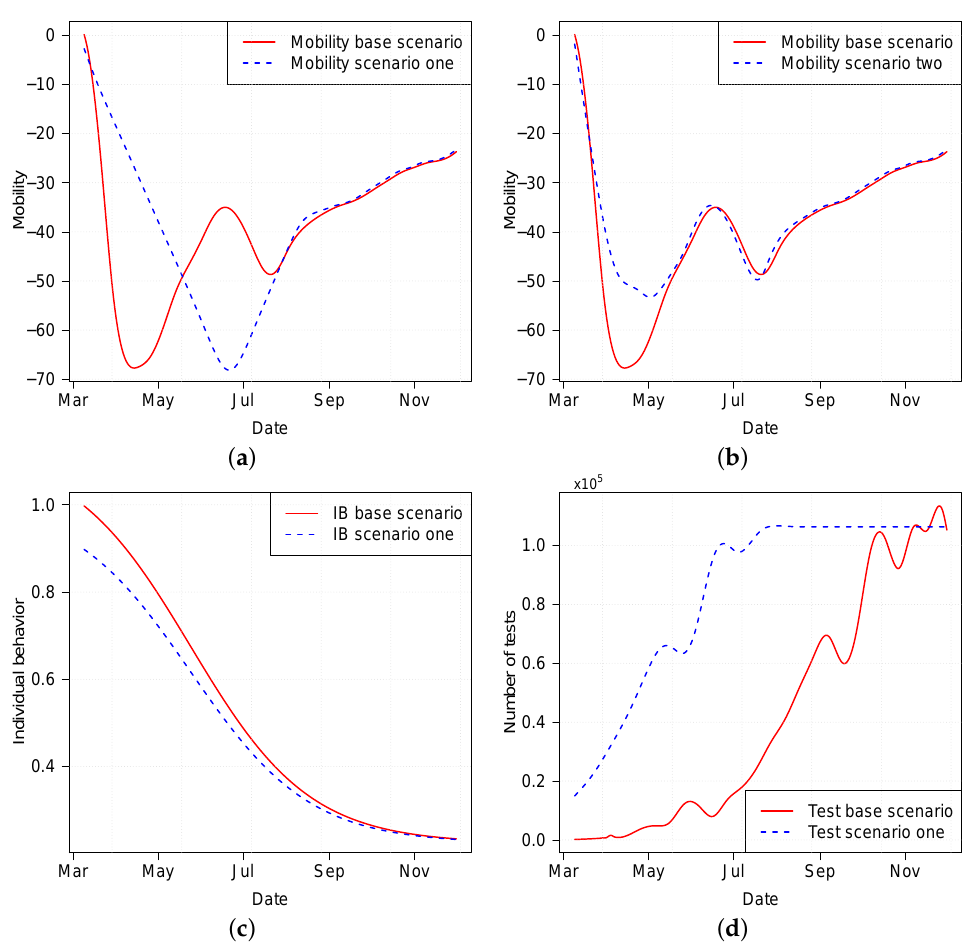
Figure 6. ( a ) Less strict lockdown scenario one; ( b ) Less strict lockdown scenario two. ( c ) Individual behavior scenario one; ( d ) Testing scenario one.